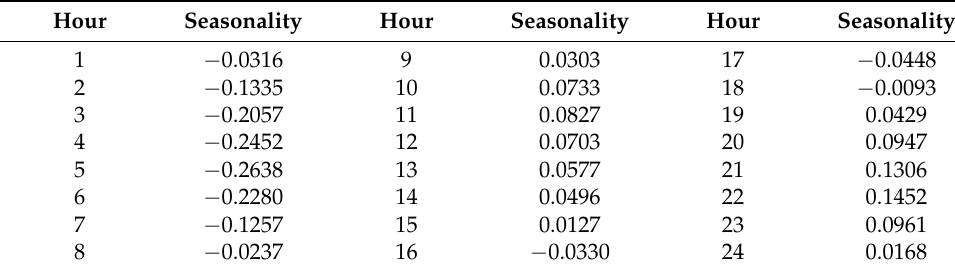
Figure 6. Logarithm of hourly seasonality in electricity prices. Table 3. Deterministic parameters calculated with daily prices.